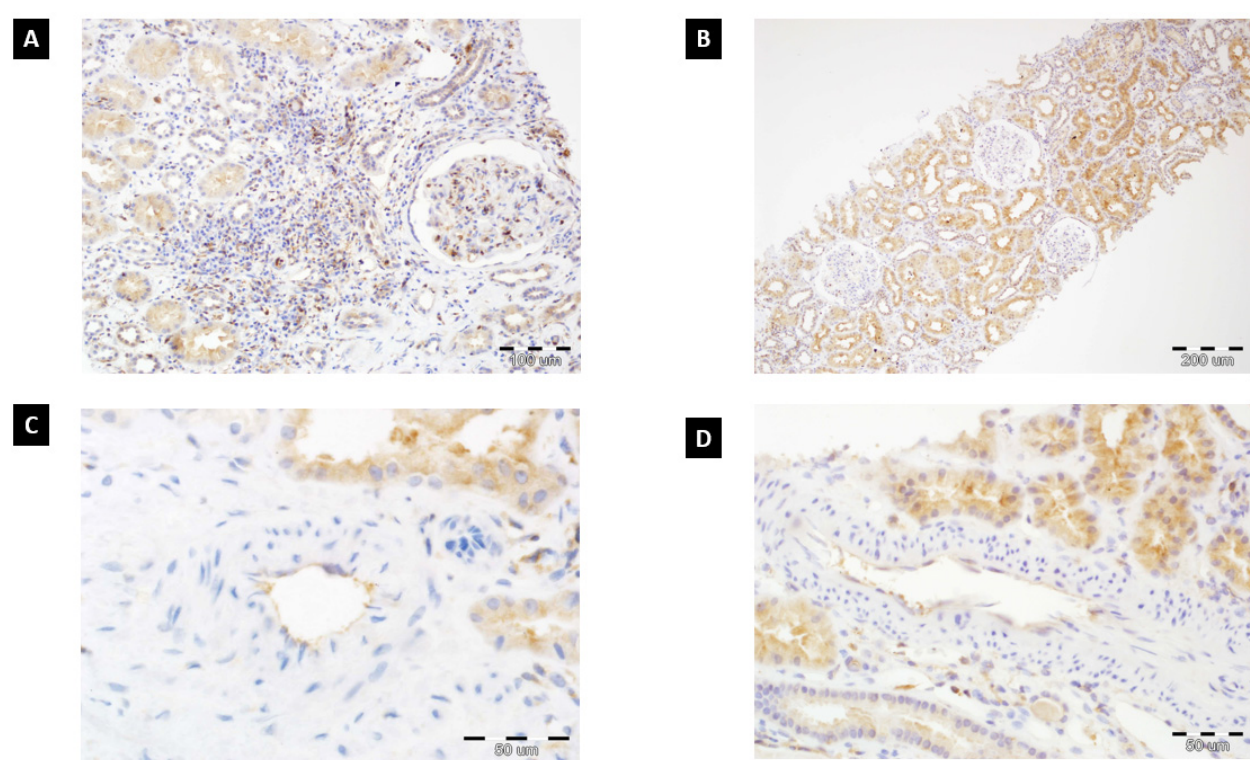
Figure 1. ( A ) High ETAR expression in tubular epithelium, glomerulus, and renal interstitium (chronic inflammatory cells and stromal fibroblasts) (200×, hematoxylin). ( B ) ETAR expression predominantly located in tubular epithelium (100×, hematoxylin). ( C ) ETAR immunoreactivity in endothelial cells of artery with focal expression in tubular epithelium (600×, hematoxylin). ( D ) High ETAR expression in tubular epithelium with immunoreactivity in endothelial cells (400×, hematoxylin).